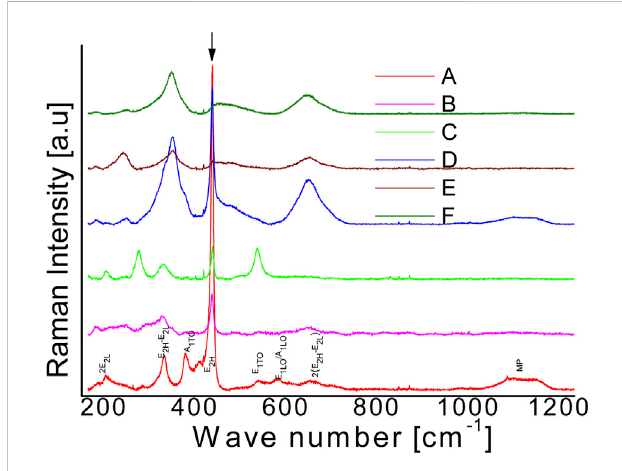
FIGURE 3 Micro Raman spectra taken at ambient temperature for samples (A to F) with varying concentrations of iron in ZnO (0% – 50%). The typical phonon modes of the wurtzite ZnO crystal are indicated at the corresponding spectral places in the bottom-most spectrum.